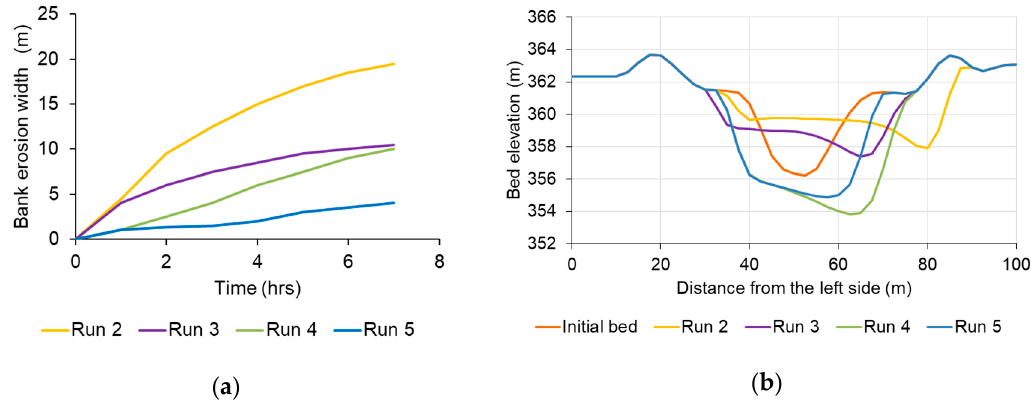
Figure 10. ( a ) Temporal change of the right bank erosion width, ( b ) transverse profile of riverbed elevation at 7 h at Kyusen Bridge, where Run 2 indicates the simulation in flow discharge of 300 m 3 /s with sediment supply, Run 3 indicates the simulation in flow discharge of 200 m 3 /s with sediment supply, Run 4 indicates the simulation in flow discharge of 300 m 3 /s without sediment supply, and Run 5 indicates the simulation in flow discharge of 200 m 3 /s without sediment supply.